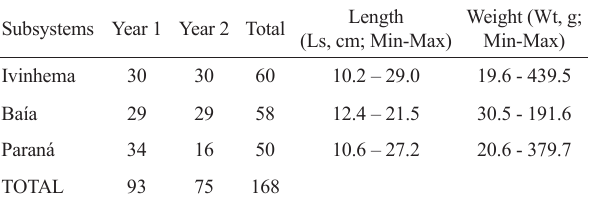
Table 2. Number of individuals of Hemiodus orthonops captured in the upper Paraná River floodplain in years 1 (June and September/2013) and 2 (June and September/2014). Ls = standard length, cm = centimeters, Wt = total weight, g = grams, min = minimum, max = maximum.